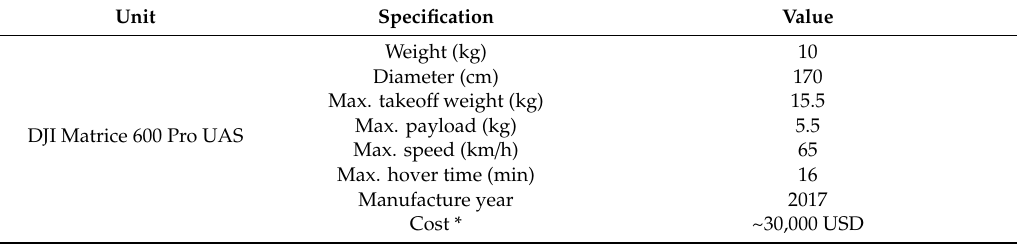
Table 1. Specifications of UAS with LiDAR and IMU. GNSS: Global Navigation Satellite